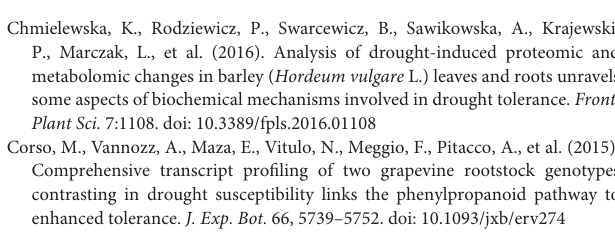
Supplementary Figure 2 | Gas exchange with shared and divergent responses. Supplementary Figure 3 | HPLC chromatograms of cowpea samples. Supplementary Figure 4 | Mapping of root metabolites in pathways. Supplementary Figure 5 | PCA with element and organic solutes. Supplementary Table 1 | Soil data. Supplementary Table 2 | GC-TOF-MS data. Supplementary Table 3 | LC-DAD data. Supplementary Table 4 | Gas exchange and chlorophyll fluorescence data. Supplementary Table 5 | MANOVA data. Supplementary Table 6 | PCA loadings. Supplementary Table 7 | Yield-metabolites